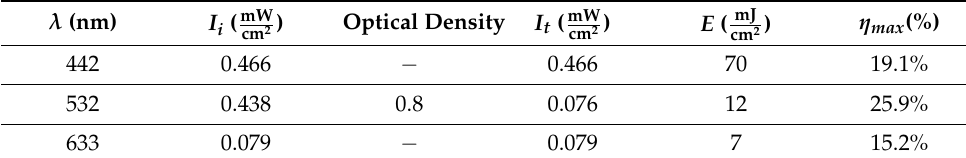
Table 5. Laser intensities, optical density of the filters used, intensity after filtering, exposure for which higher and similar efficiency were obtained for each wavelength and maximum efficiency obtained for each of the three wavelengths (MH-B).